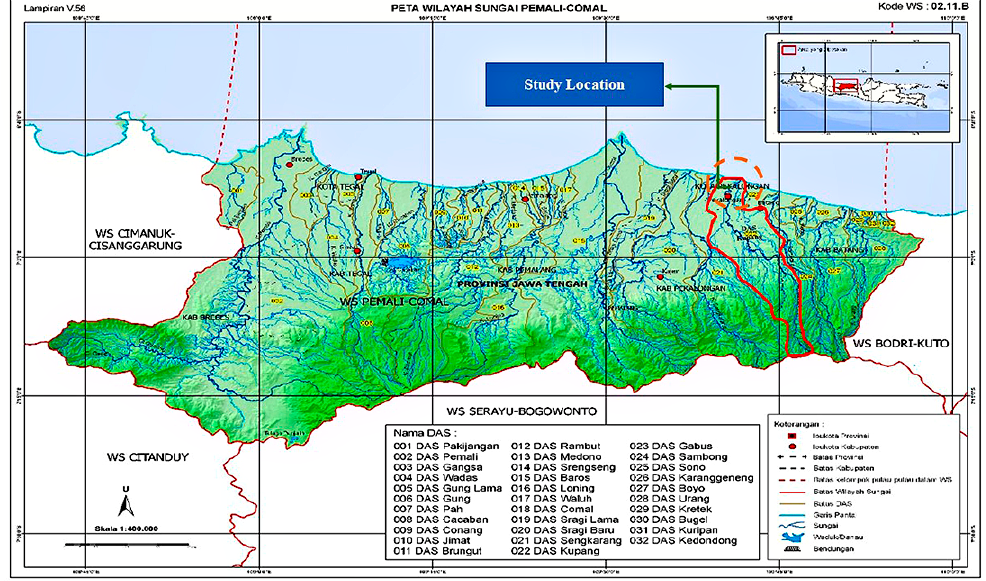
Figure 2. Map of Study Location for the Kupang Watershed in the Pemali Comal River